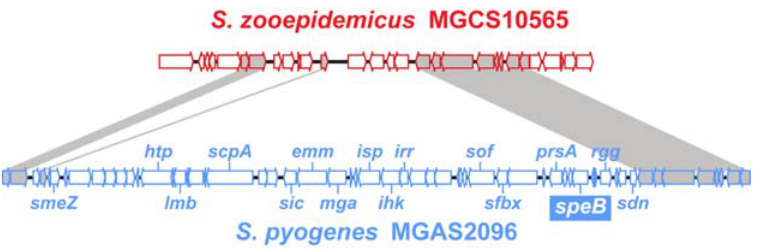
Figure 8. Schematic of the SpeB encoding region. Illustrated is an alignment of the SpeB encoding region of the S. pyogenes neprhitogenic serotype M12 strain MGAS2096 genome (shown in blue) with the corresponding region of the S. zooepidemicus strain MGCS10565 genome (shown in red). speB and several flanking genes (e.g. smeZ , sof , and sfbX ) are not present in the S. zooepidemicus strain MGCS10565 genome.